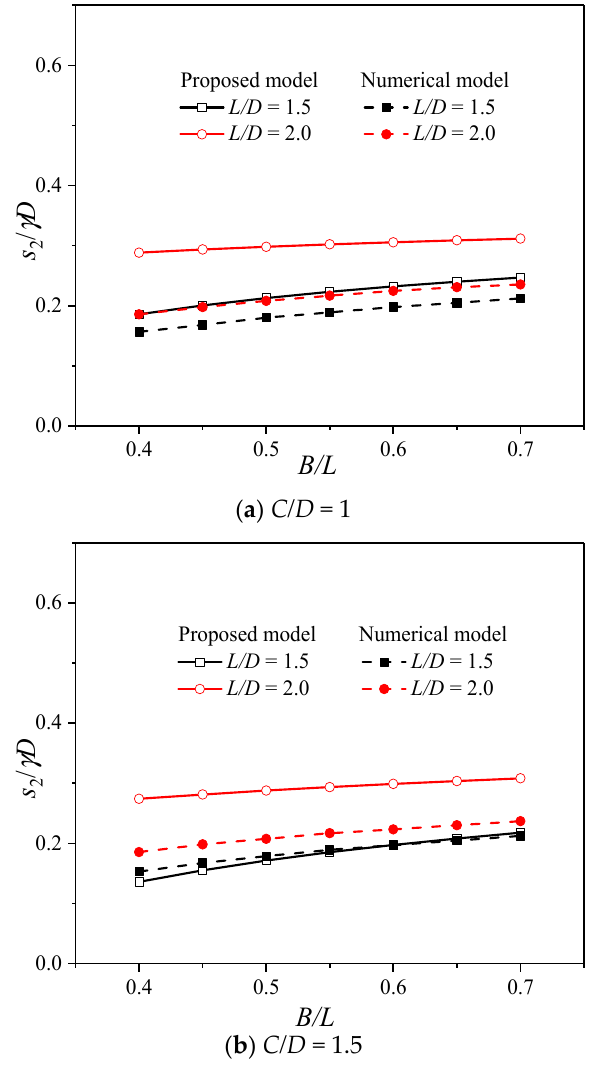
Figure 10. Variations in s 2 / γ D depending on ϕ ’ at typical ϕ = 25 ◦